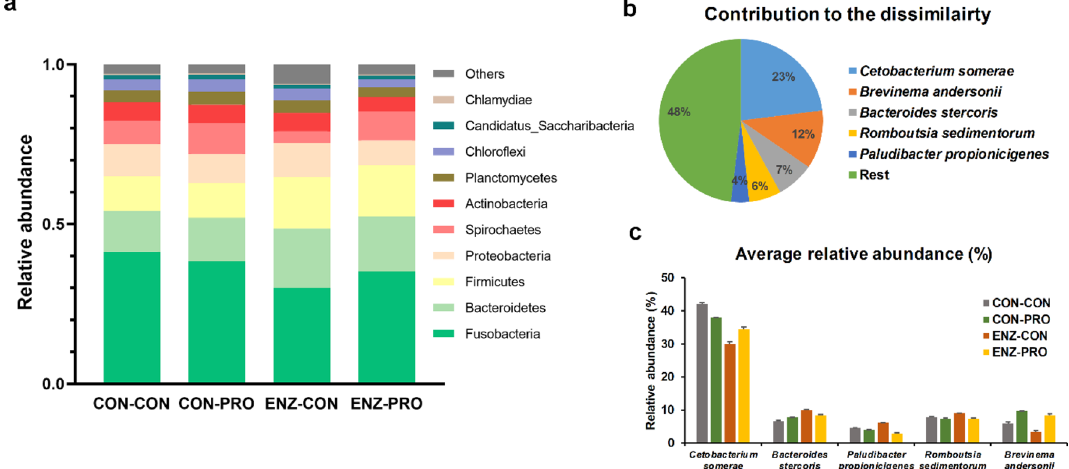
Figure 5. Microbial community composition, showing ( a ) the relative abundance of the most abundant phyla, ( b ) the top 5 species contributing the microbial composition dissimilarity among the dietary groups and ( c ) the relative abundance of the top 5 species. CON-CON (n = 11), no enzymes or probiotics added; CON-PRO (n = 12), probiotics added; ENZ-CON (n = 9), enzymes added; ENZ-PRO (n = 12), enzymes and probiotics added; error bars indicate standard error of means.